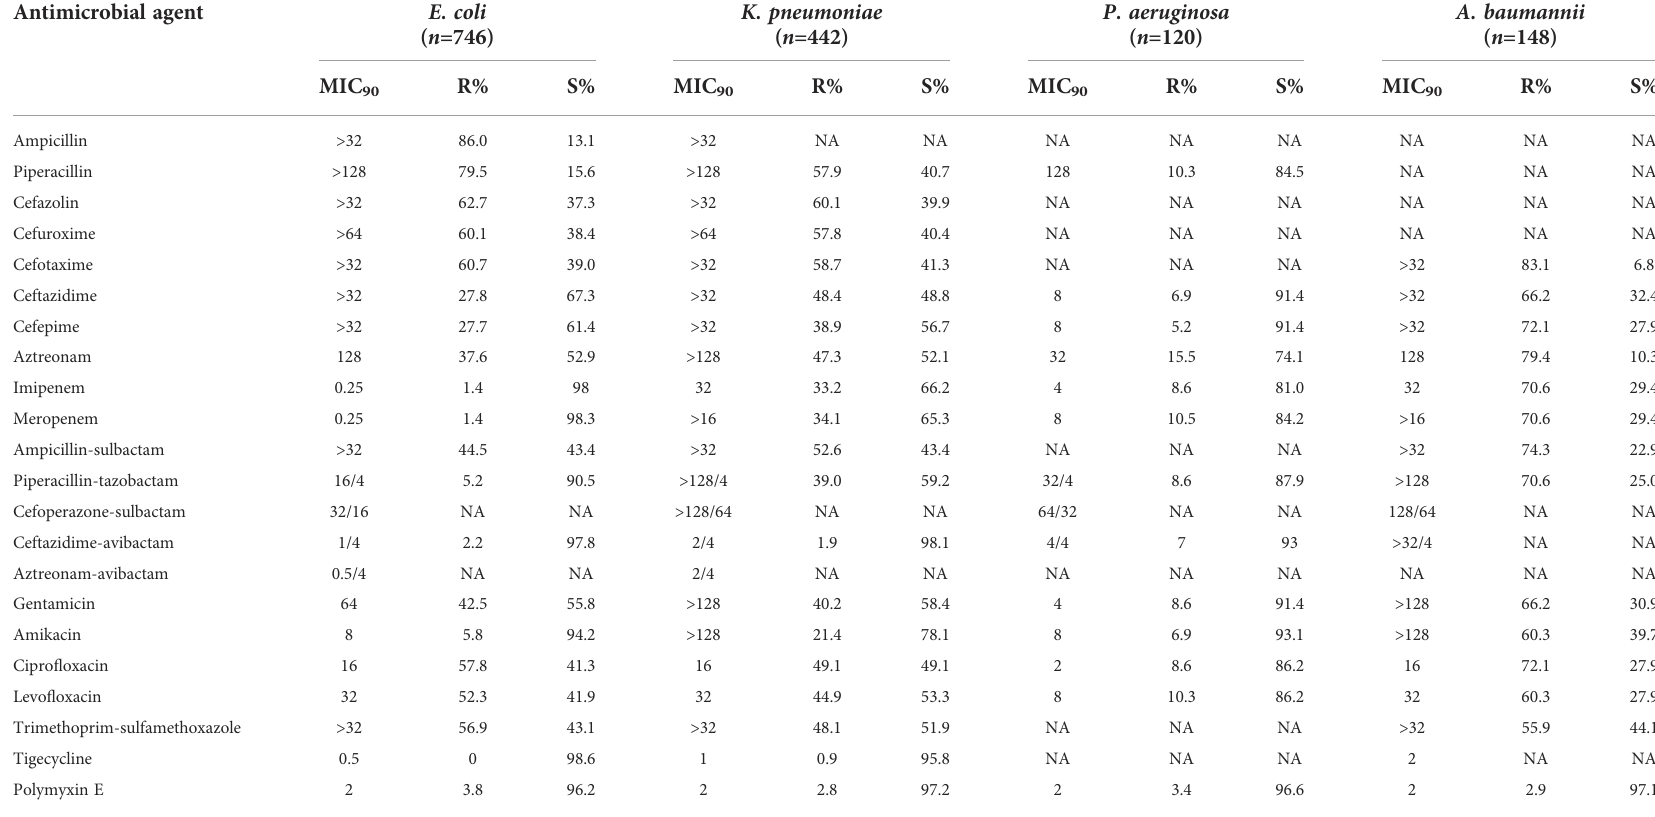
TABLE 6 Susceptibility of Gram-negative bacilli isolated from bloodstream infections to antimicrobial agents. Antimicrobial